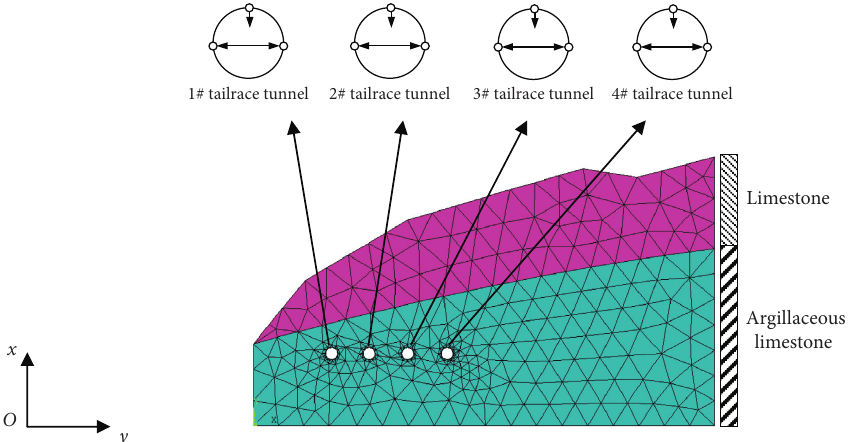
Figure 6: Model of the tunnel of the finite element